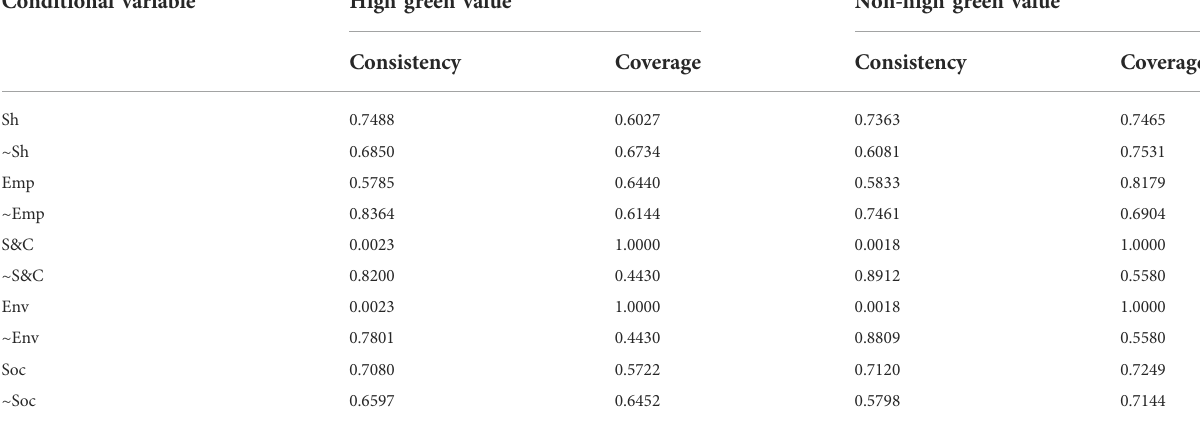
TABLE 3 Analysis of necessary conditions (full